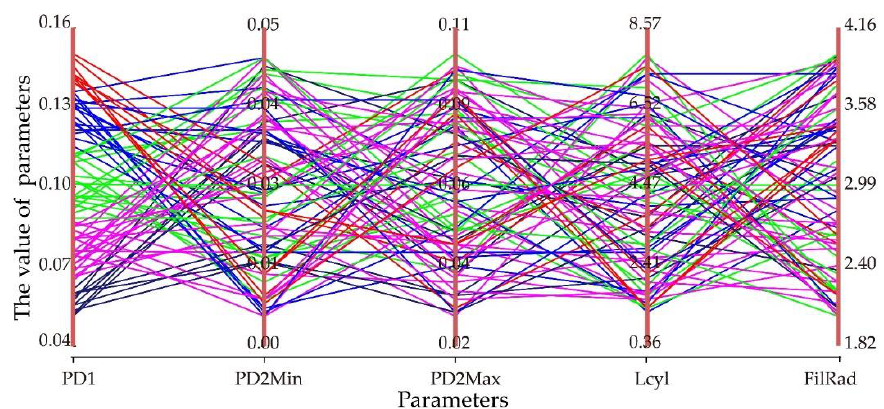
Figure 3. Cobweb diagram of the value of parameters. The same broken line represents a group of parameter settings, and multiple colors represent multiple groups of parameters. This figure shows the process of parameter sampling for sensitivity analysis.